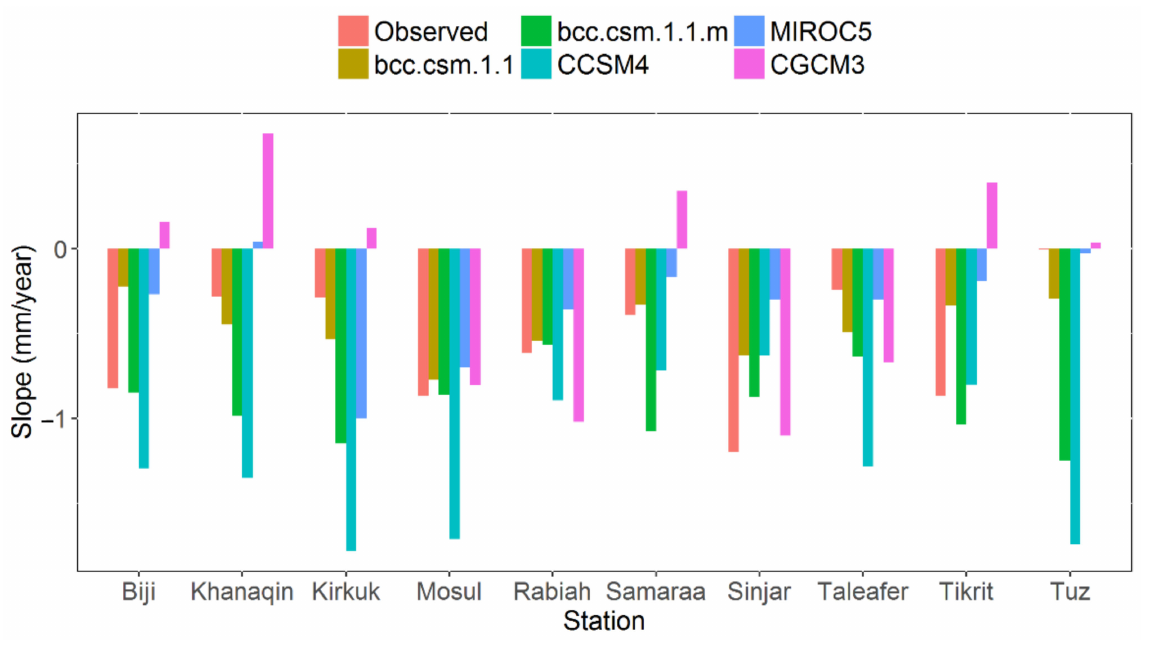
Figure 12. Linear trends of annual rainfall for the observed and simulated time series using the Mann–Kendall trend test for the median condition in zone 2.